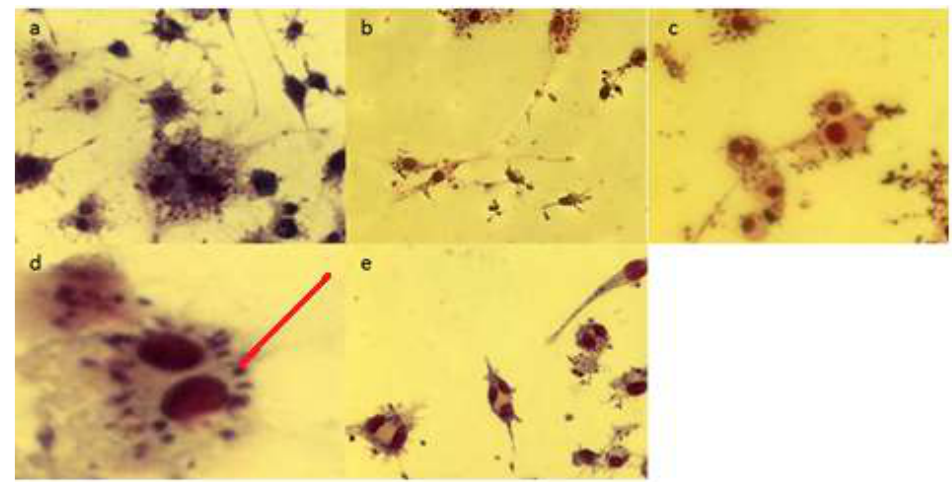
Figure 3. Amastigotes inside macrophages shown with arrows: ( a ) untreated control, ( b ) treated with quercetin, ( c ) treated with gallic acid, and ( d ) treated with rutin at the highest concentration tested (500 µg/mL) after 72 h of incubation, stained with Giemsa stain. ( e ) SSG 250 µg/mL was used as positive control. Images were taken with a Nikon microscope.